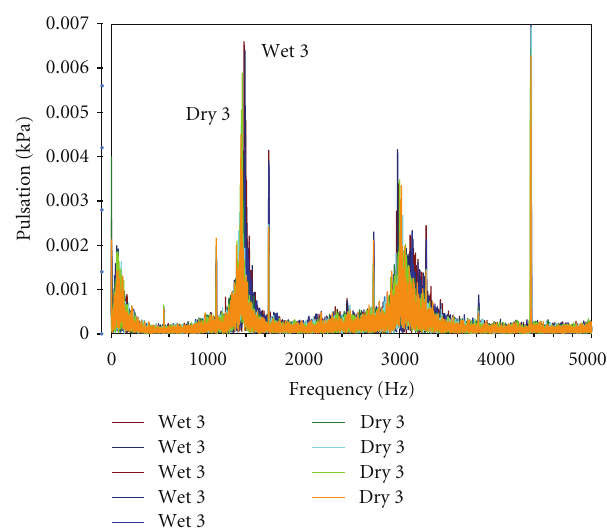
Figure 12: Comparison of raw frequency spectra wet versus